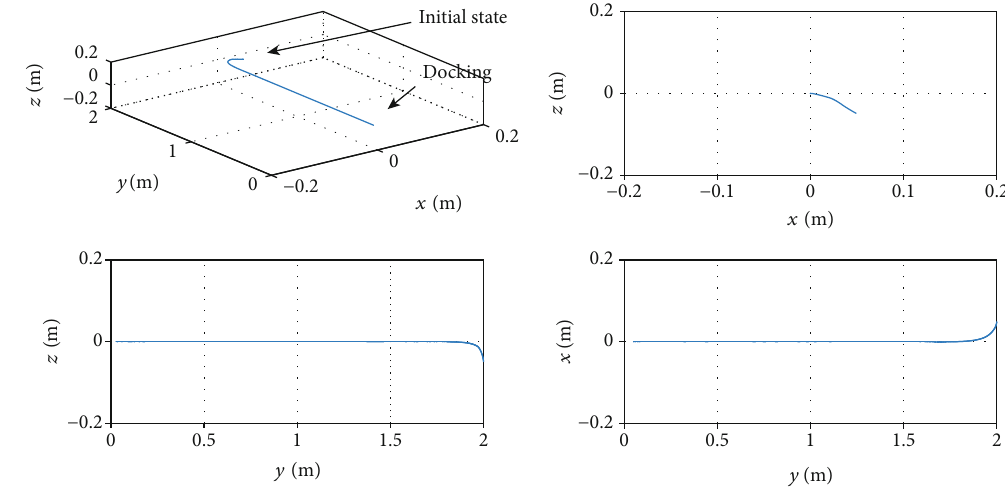
Figure 16: Three-dimensional representation and projections of relative